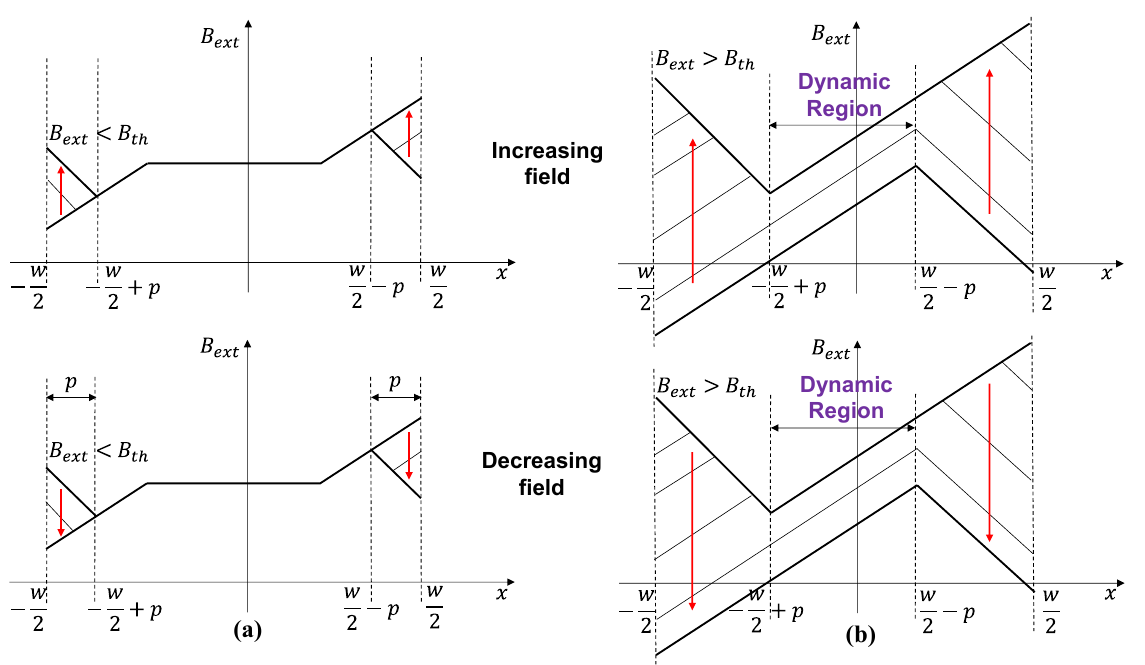
Figure 13. Magnetic profile inside an HTS conductor when it carries a DC current under an AC magnetic field. ( a ) The applied field B ext is smaller than the threshold B th , ( b ) the applied field B ext exceeds the threshold B th and creates the dynamic region. Adapted from